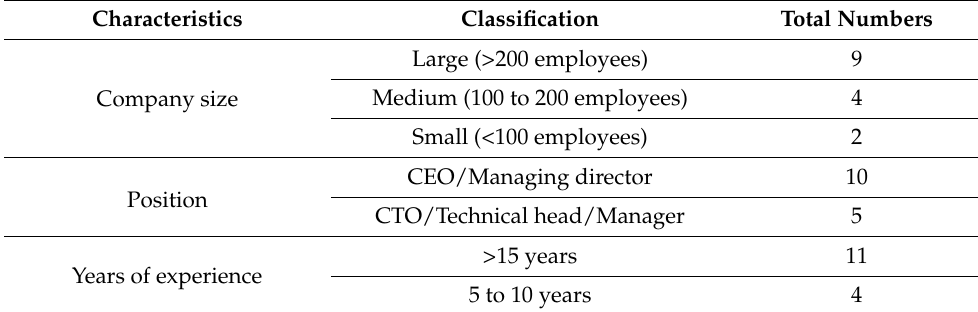
Table 2. Respondents’ details for FCM.